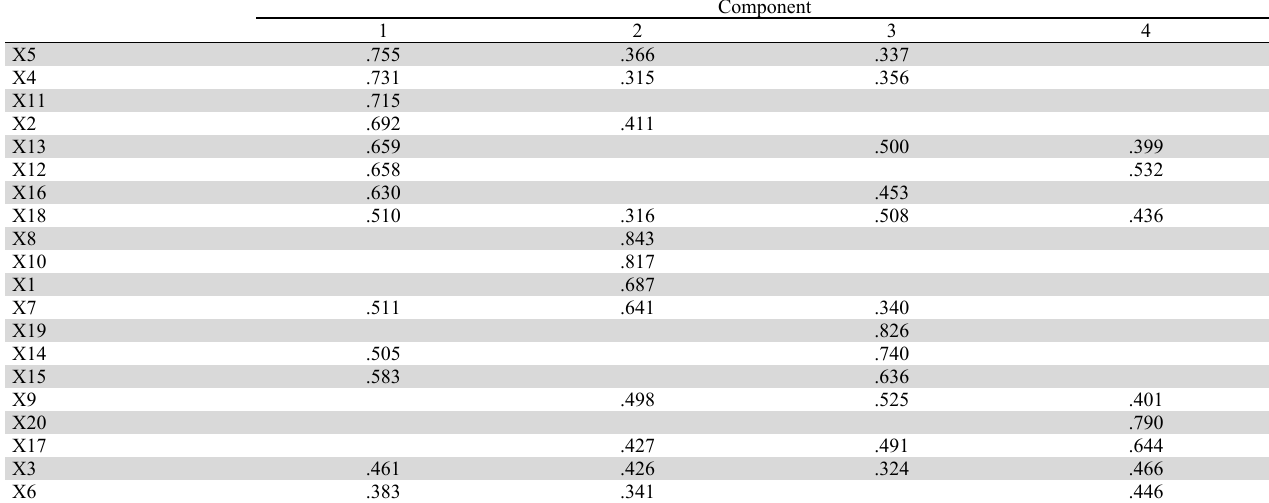
Extraction Method: Principal Component